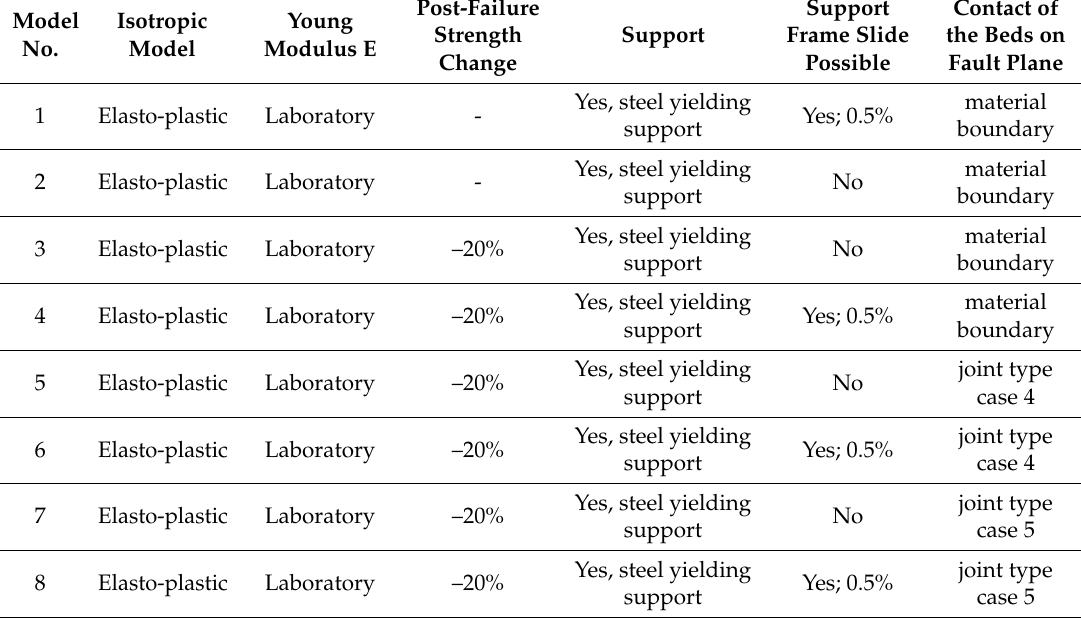
Table 6. Physical models for the roadway section inside the fault